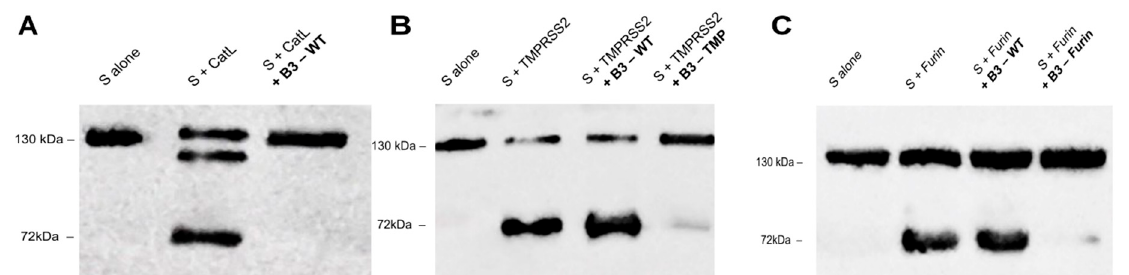
Figure 3. SerpinB3 variants can block cleavage of recombinant S protein by proteases in vitro. ( A ) Western blot of S protein cleavage by CatL in the presence of SerpinB3 WT after 5 h incubation ( B ) Western blot of S protein cleavage by TMPRSS2 in the presence of SerpinB3 variants (B3-WT and B3-TMP) after overnight incubation. ( C ) Western blot of S protein cleavage by furin in the presence of SerpinB3 variants (B3-WT and B3-Furin) after overnight incubation. S protein containing a C-terminal Flag tag was assessed by anti-Flag antibody. Representative data from three independent experiments are shown.